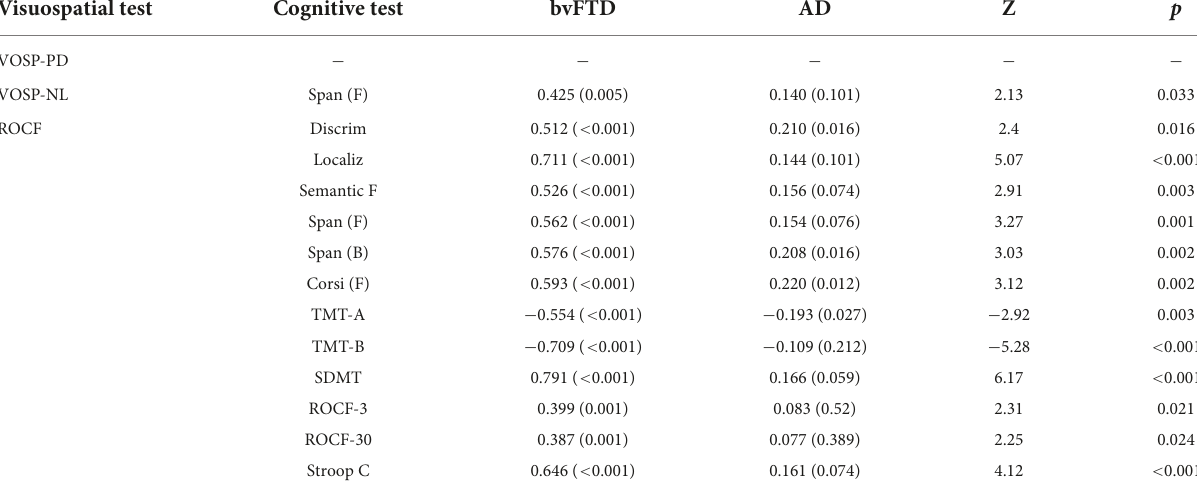
TABLE 3 Statistically significant comparisons of correlation coefficients of bvFTD and AD between visuospatial test and other neuropsychological tests. Visuospatial test Cognitive test bvFTD